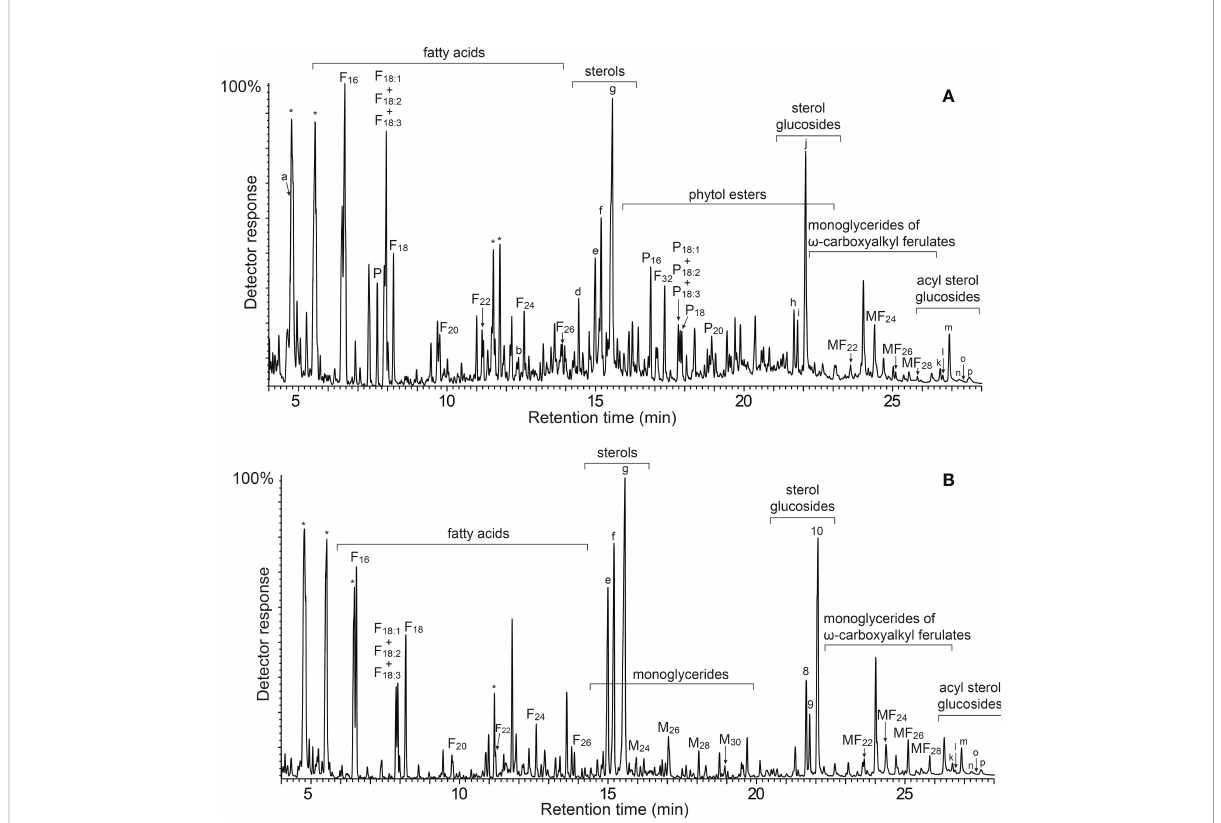
FIGURE 2 GC-MS chromatograms of the TMS-ether derivatives of the lipid extracts from (A) the rind, and (B) the pith of papyrus stems. F(n), n -fatty acid series; M(n), monoglycerides; P, phytol; P(n), phytol esters series; MF(n), monoglycerides of w -carboxyalkyl ferulates. Labels for selected compounds are: a, phytadiene; b, squalene; c, stigmasta-3,5,22-triene; d, a -tocopherol; e, campesterol; f, stigmasterol; g, sitosterol; h, campesteryl 3- O - b - D -glucopyranoside; i, stigmasteryl 3- O - b - D -glucopyranoside; j, sistosteryl 3- O - b - D -glucopyranoside; k, campesteryl (6 ′ - O - palmitoyl)-3- O - b - D -glucopyranoside; l, stigmasteryl (6 ′ - O -palmitoyl)-3- O - b - D -glucopyranoside; m, sistosteryl (6 ′ - O -palmitoyl)-3- O - b - D - glucopyranoside; n, campesteryl (6 ′ - O -stearoyl/oleyl/linoleyl/linolenyl)-3- O - b - D -glucopyranoside; o, stigmasteryl (6 ′ - O -stearoyl/oleyl/linoleyl/ linolenyl)-3- O - b - D -glucopyranoside; p, sistosteryl (6 ′ - O -stearoyl/oleyl/linoleyl/linolenyl)-3- O - b - D -glucopyranoside. * Unknown